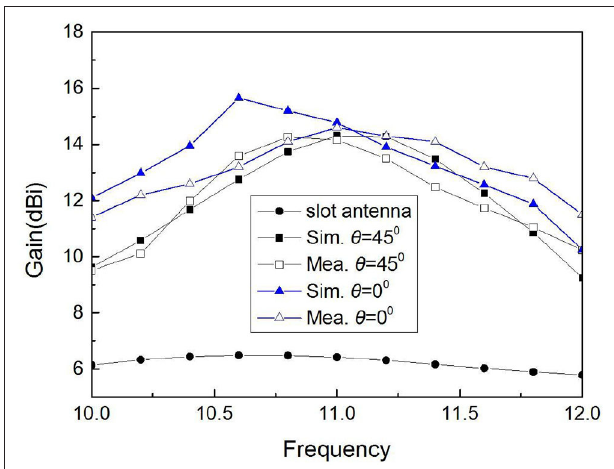
FIGURE 10 | Measured and simulated peak gains vs. frequency with different rotation angle.